Question: From the figure, is the trend upward or downward?
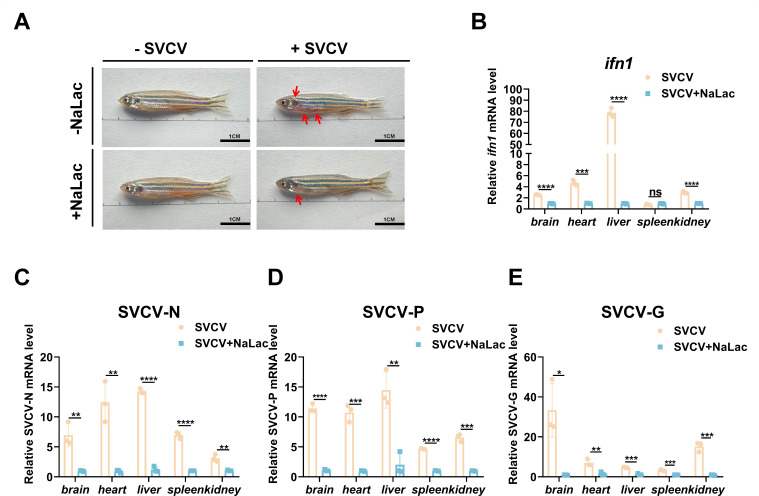
Answer: increasing